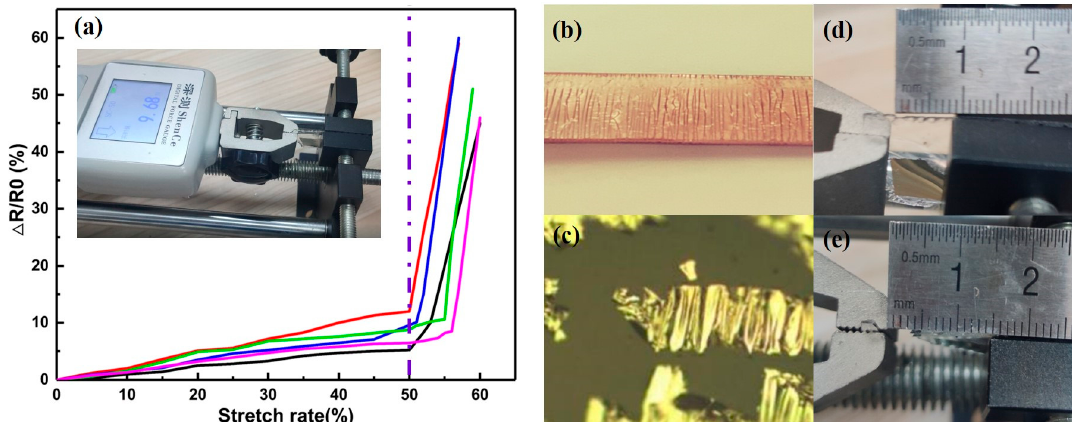
Figure 4. ( a ) Relationship between pull-up rate and resistance change. ( b ) The intuitive structure of the surface of the stretching electrode. ( c ) Microstructure of stretched metal electrode surface. ( d ),( e ) Comparison of the electrode length before and after stretching, 9 mm and 15 mm.